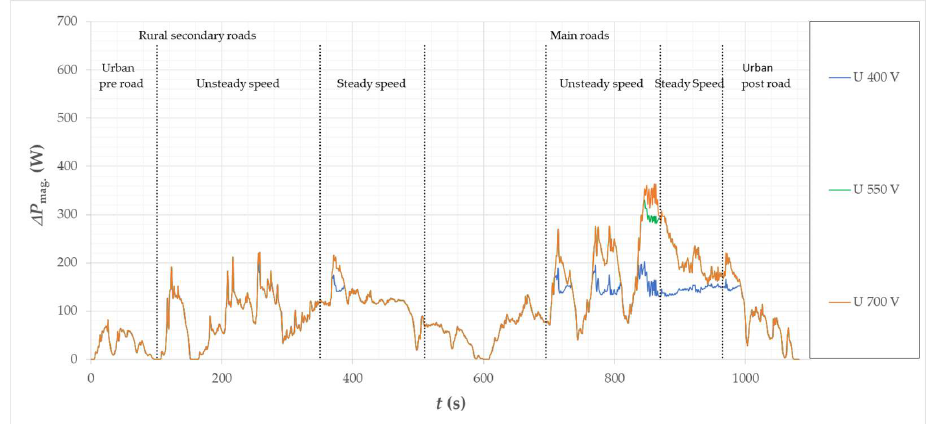
Figure 26. Calculated loss waveforms in magnets of the motor for the considered vehicle in the Artemis Road driving cycle .